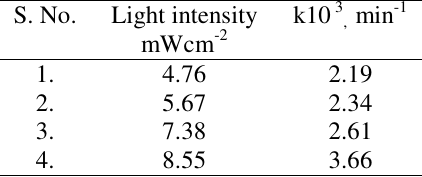
Table 5. Effect of intensity of light.